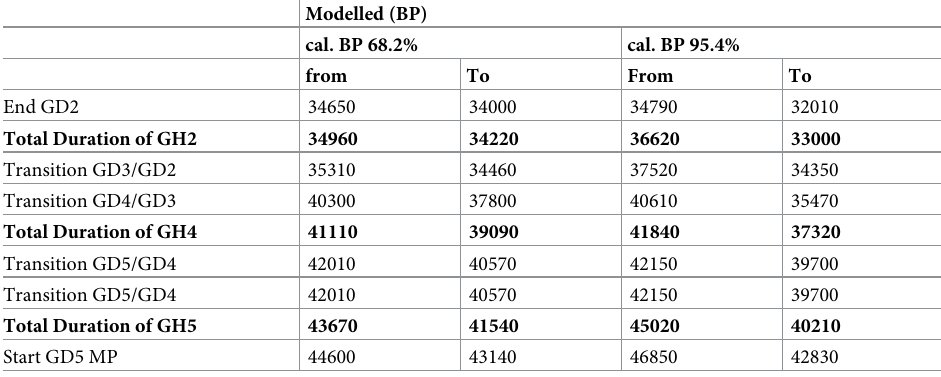
Table 7. Bayesian modelled boundaries and duration of the phases provided by the IntCal20 13 using OxCal 4.3 program [49]. Modelled (BP) To From To